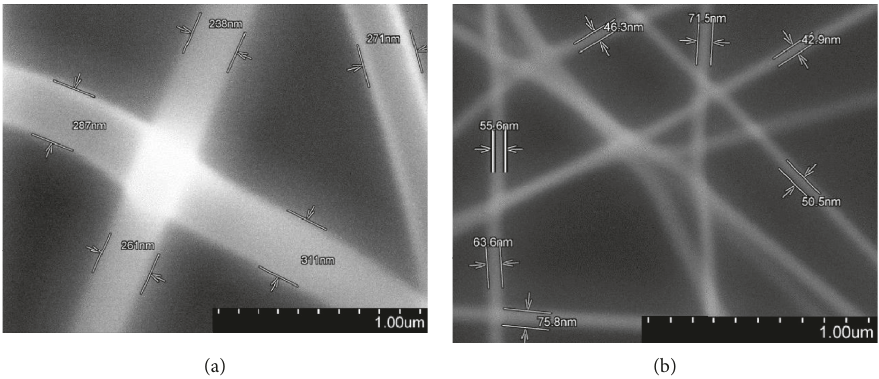
Figure 2: SEM images of IZO nanofibers before (a) and after (b) annealing.